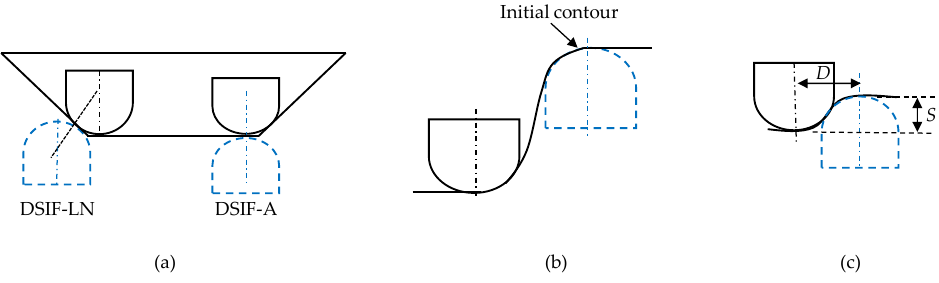
Figure 4. ( a ) Schematics of normal and aligned tool configurations in DSIF-L ( b ) DSIF-P ( c ) ADSIF.